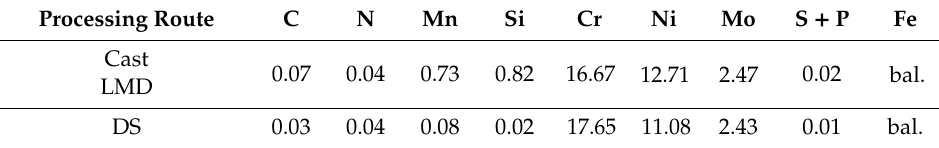
Table 2. Chemical composition of the investigated specimens measured by optical emission spectroscopy. Cast and LMD specimens were produced by the same gas atomized 316L powder. To avoid the evaporation of Mn, the composition was adjusted for directional solidification (DS). All values are given in mass%.